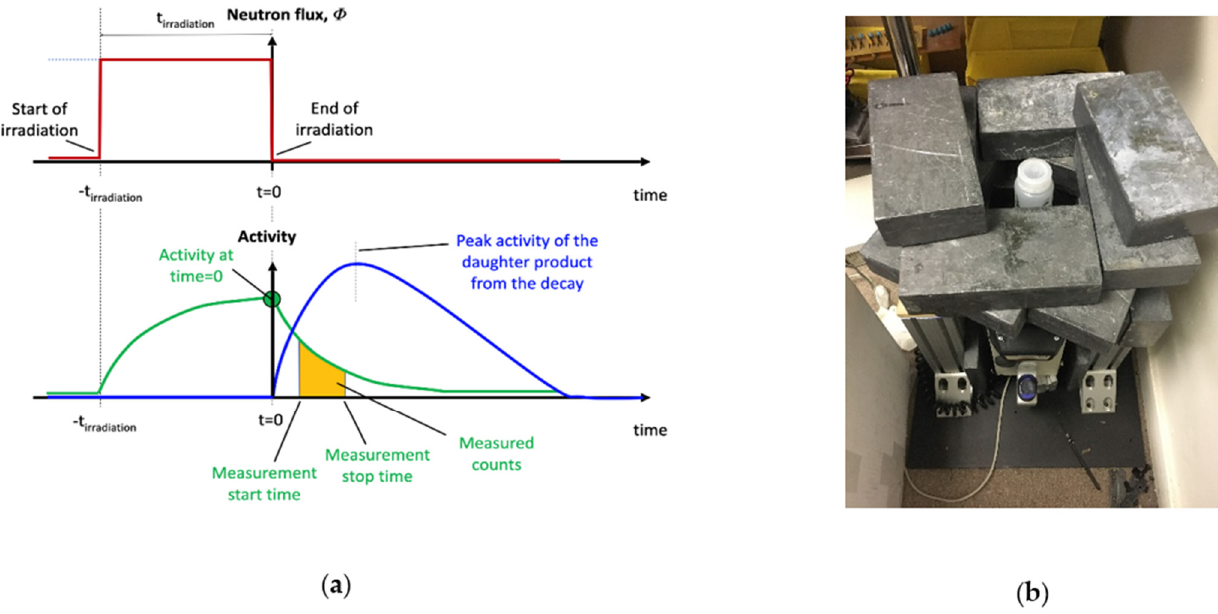
Figure 1. ( a ) Diagrammatic sketch of the irradiation time and isotope production, and ( b ) HPGE detector experimental setup and sample in a polypropylene container.